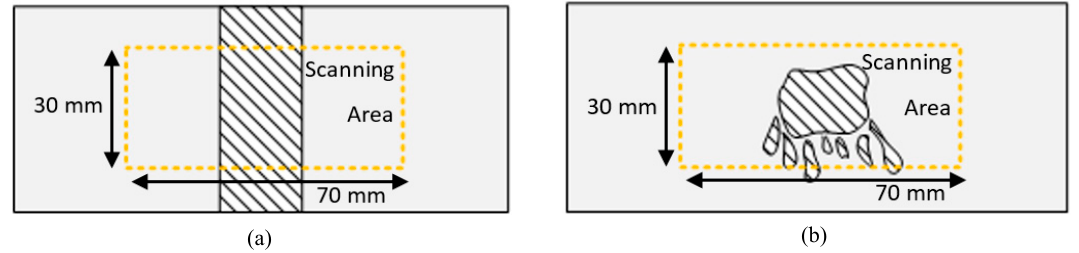
Figure 7. Schematic illustration of the scanning area of adhesive bonded aluminum ( a ) plate and ( b ) plate 2.